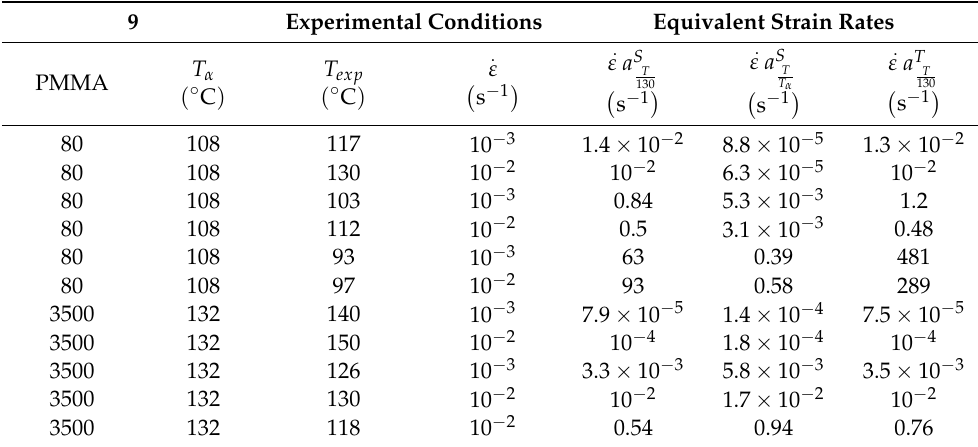
Table 2. Experimental conditions for shear tests and corresponding equivalent strain rates at 130 and at T α in shearing and tension.